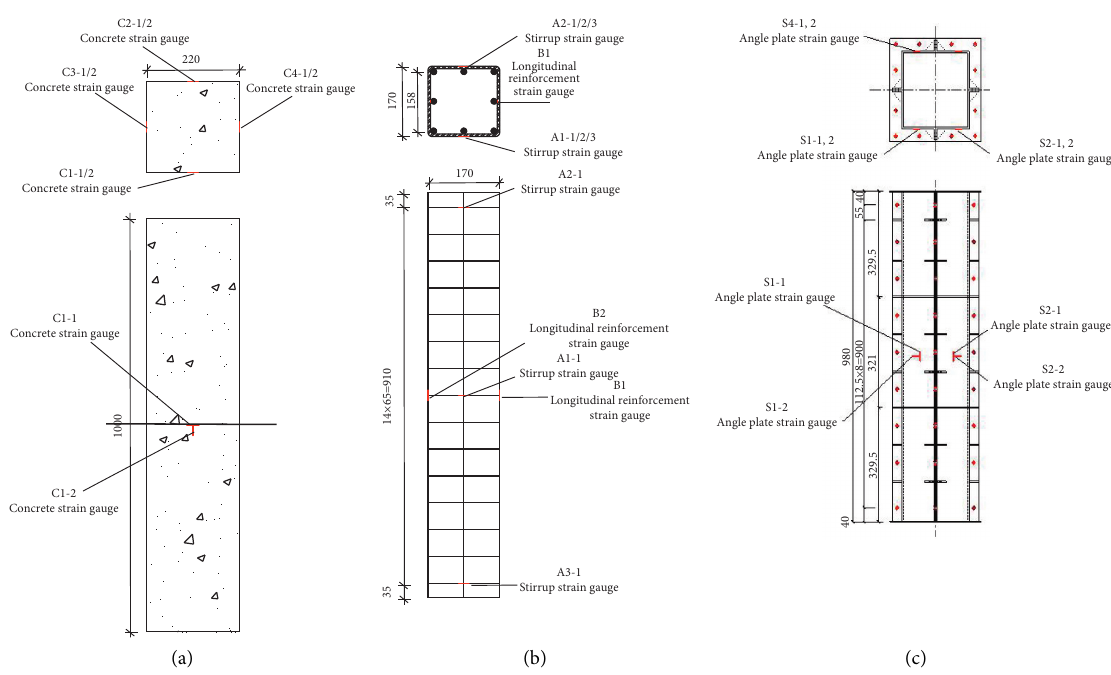
Figure 2: Details of specimens. (a) Concrete. (b) Steel bar. (c) Angle steel